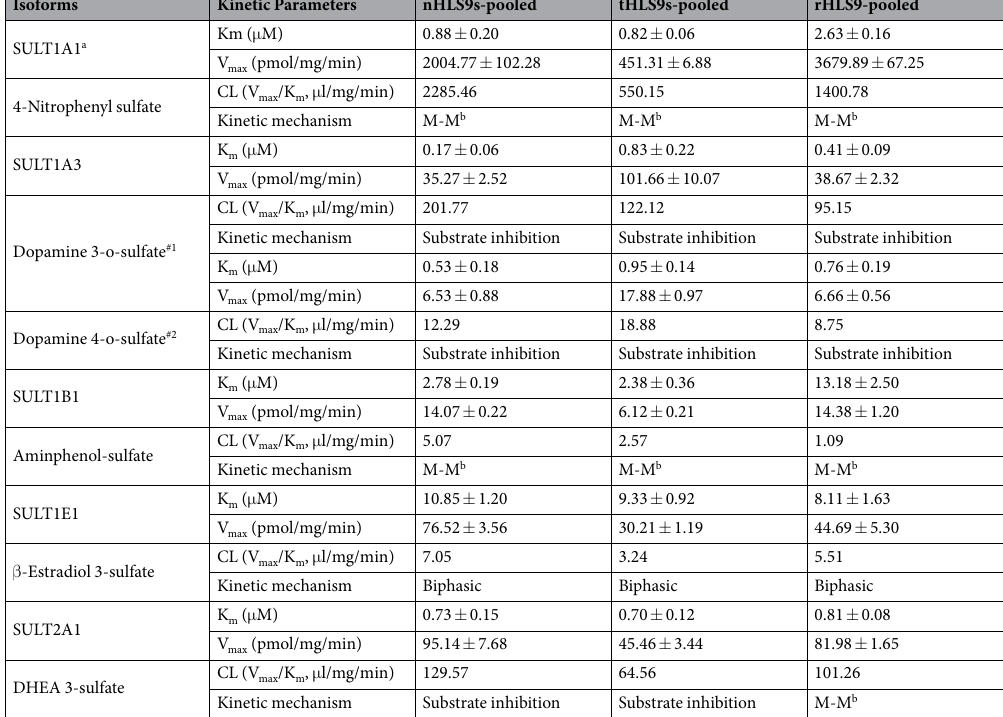
Table 2. Summarize of enzyme kinetic parameters for five SULT activities in pooled human Liver S9. a Probe substrate and its metabolite. b M-M, Michaelis-Menten. The isomers #1(Dopamine 3-o-sulfate) and #2(Dopamine 4-o-sulfate) are the two sulfation